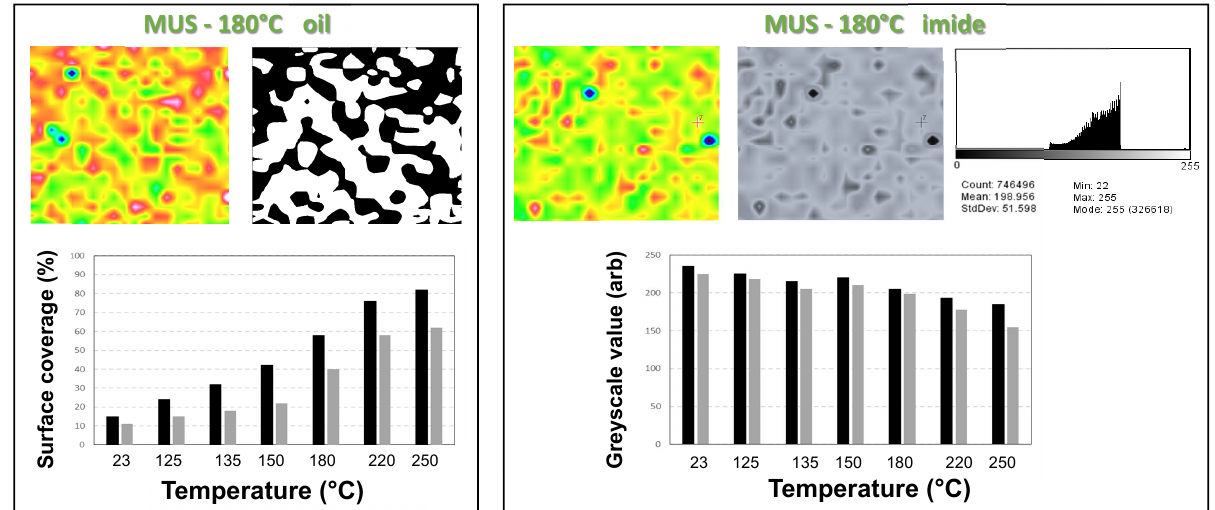
Figure 14. Quantification of chemical characteristics of SMI/SfO-PUS and SMI/SfO-MUS coatings after thermal oil release based on Raman surface mapping and image processing: ( a ) determination of oil release from surface area coverage, ( b ) determination of imide content from greyscale